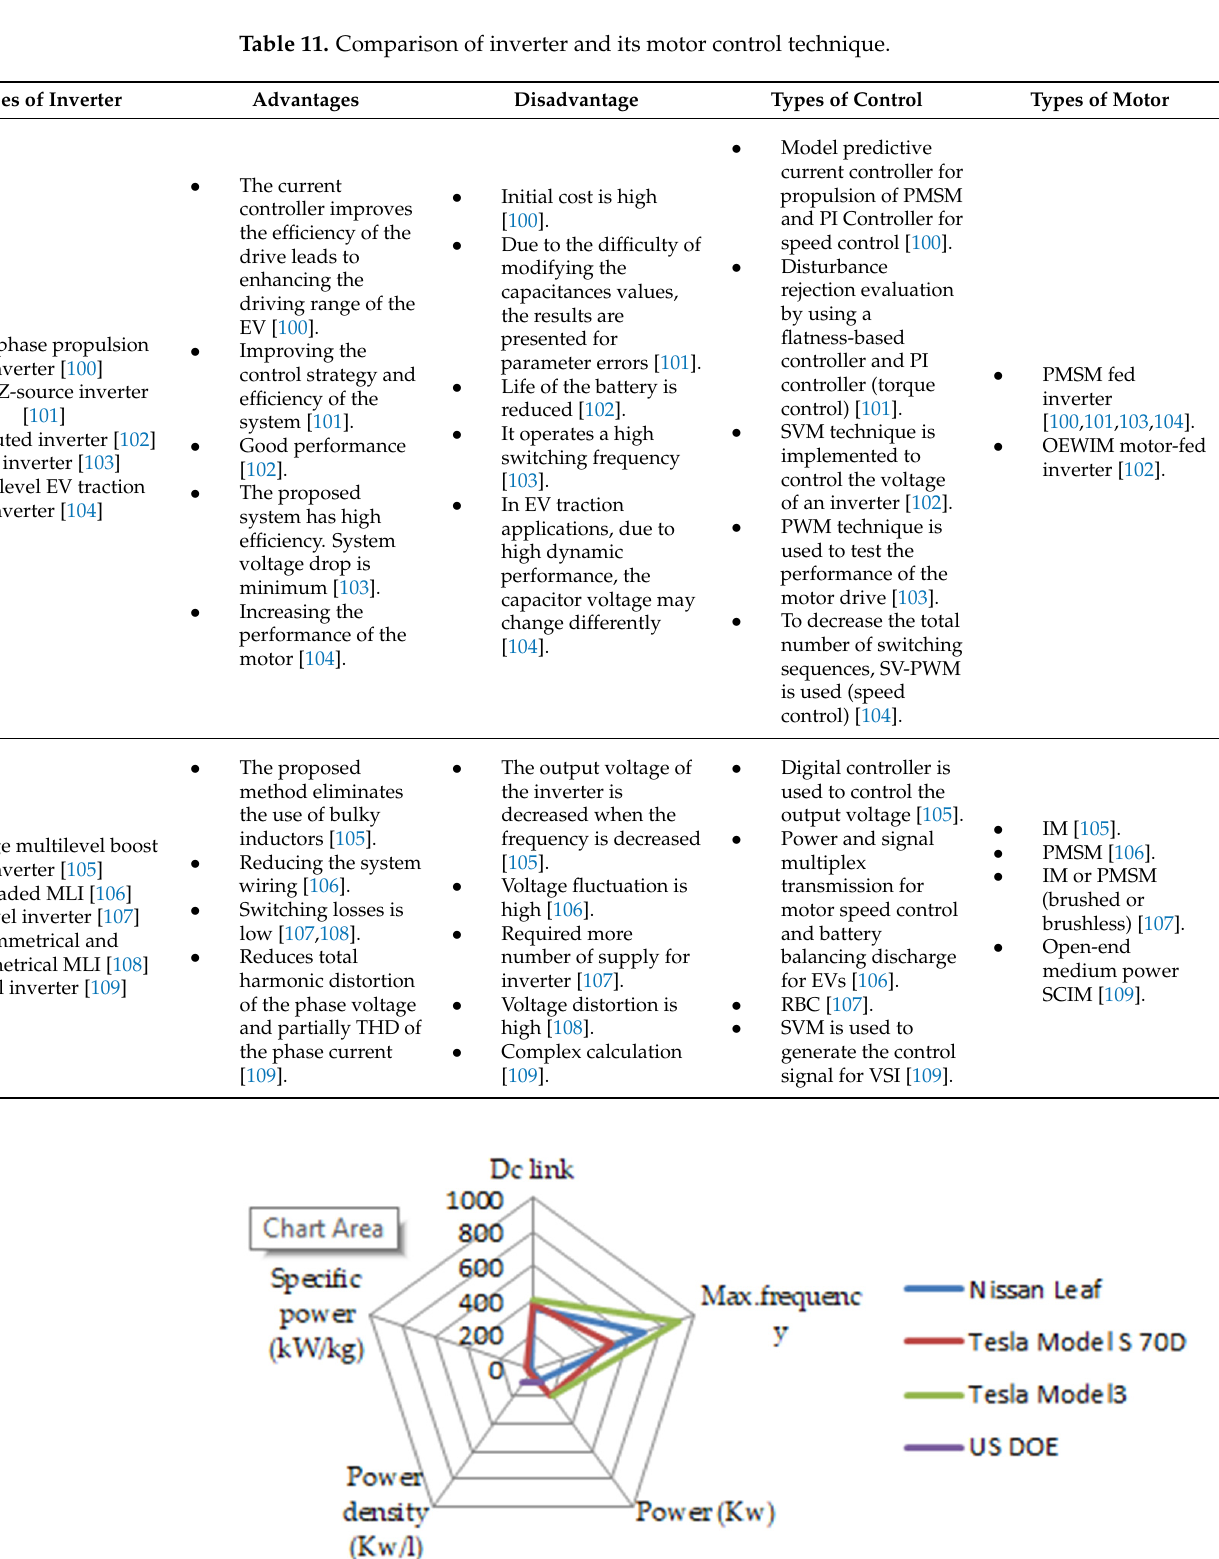
Table 11. Comparison of inverter and its motor control technique.